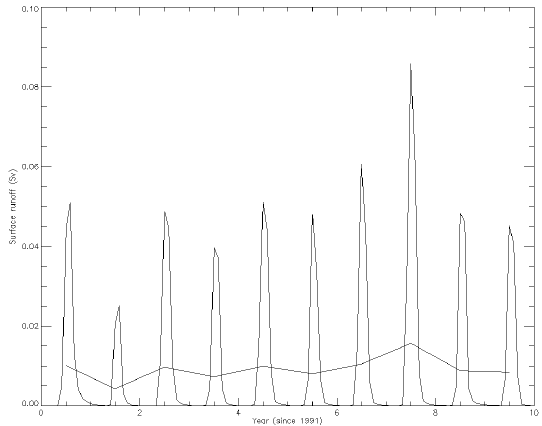
Fig. 5. Monthly and annual-mean surface runoff (Sv) from Green- land for 1991–99. This does not include the iceberg calving fluxes, which are assumed constant throughout the year. The iceberg flux is approximately equal in magnitude to the mean annual runoff in the simulation.